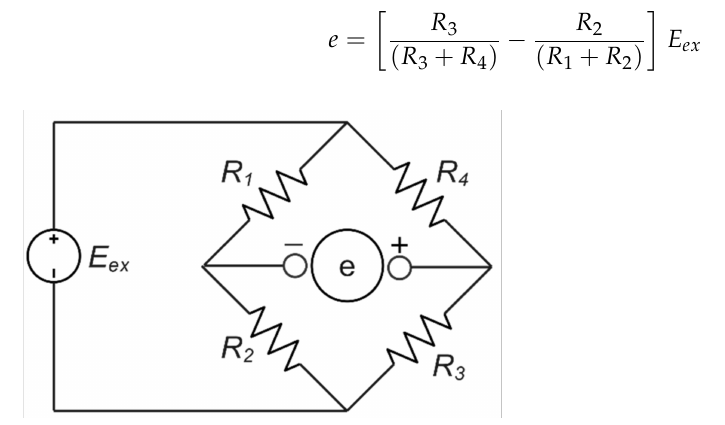
Figure 2. Wheatstone bridge